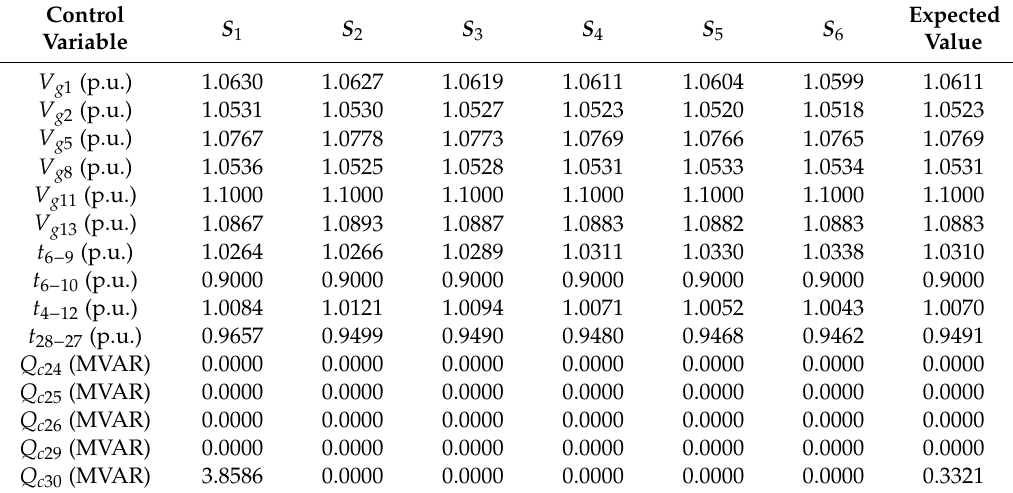
Table 14. The optimal values of the control variables among the wind scenarios for probabilistic multi-objective RPP considering the wind power generation uncertainty.